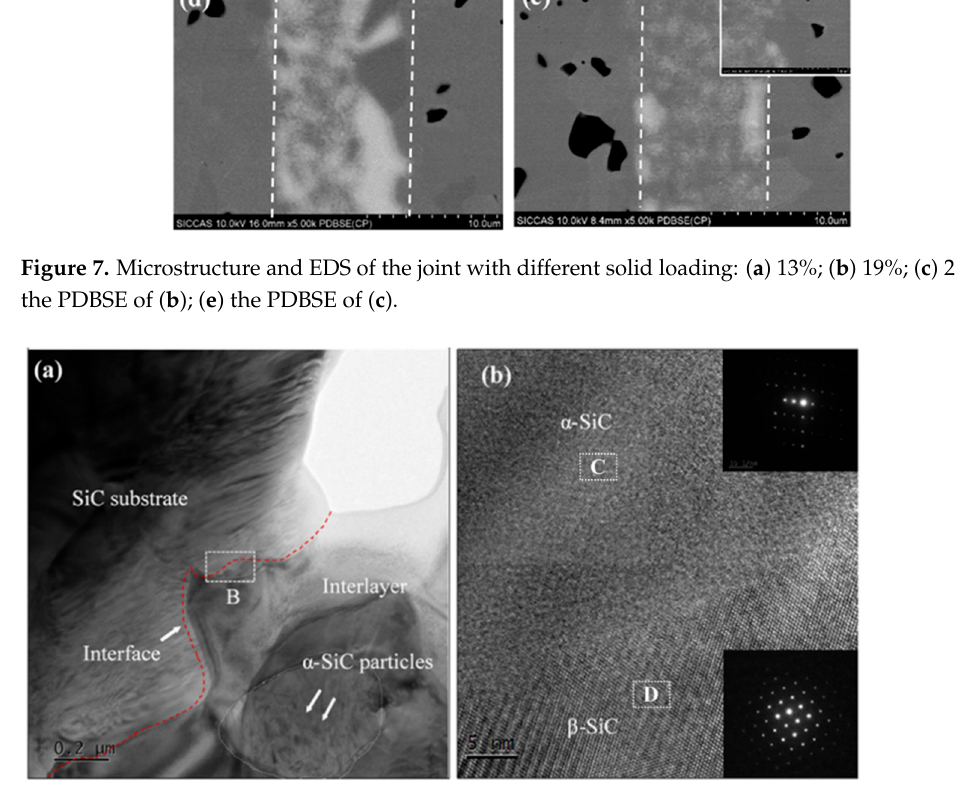
Figure 8. TEM image and the corresponding HRTEM of ( a ) SiC-SiC joint, ( b ) B regions of ( a ).